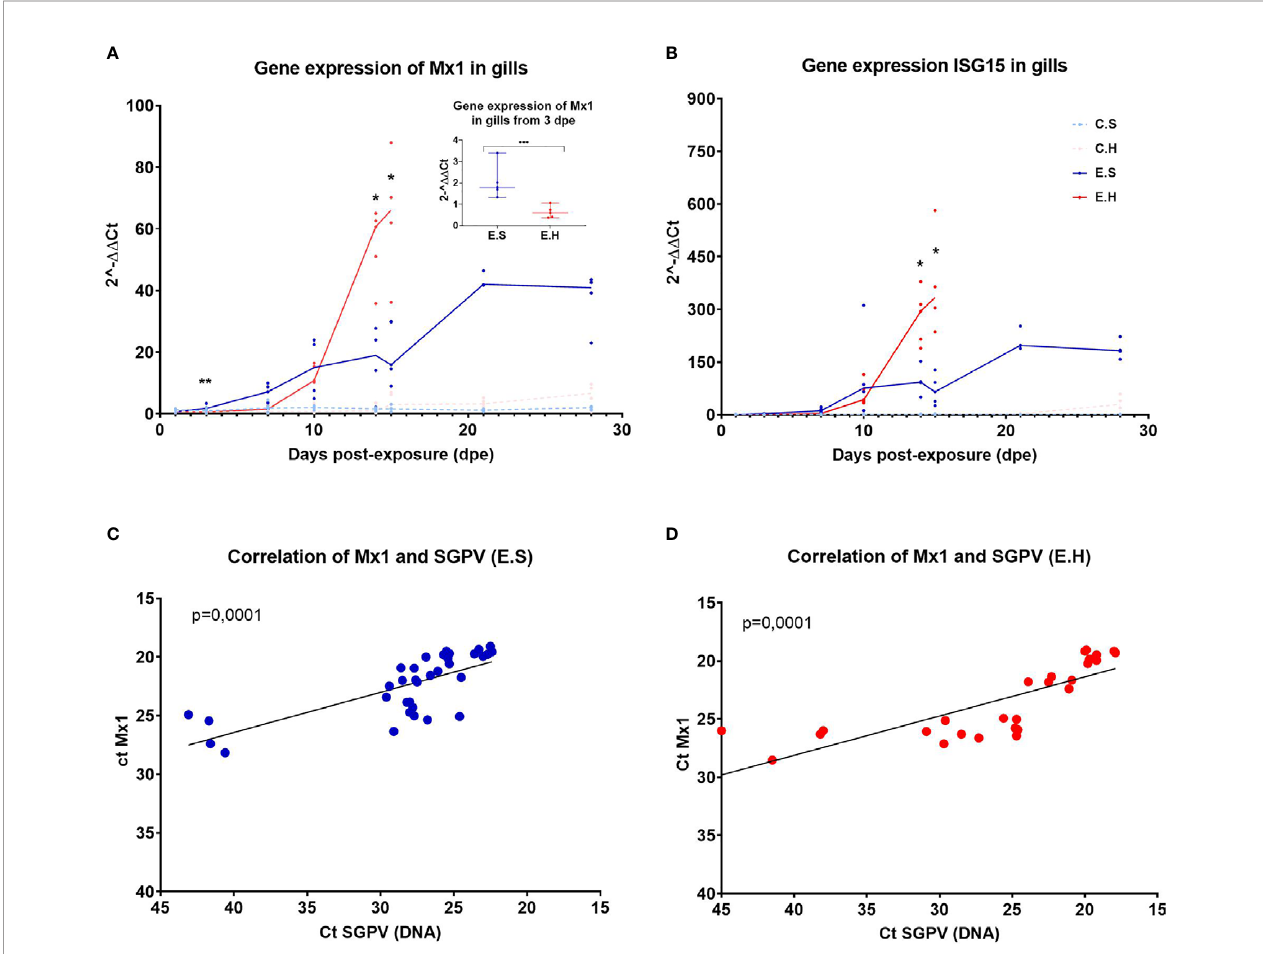
FIGURE 3 | Gene expression of Mx1 and ISG15 in gills from Atlantic salmon from the experimental trial. Each dot represents data from one individual salmon and the solid line represents the median value for each group. The signi fi cant differences are calculated between the two infected groups. (A) Gene expression of MX1 for all groups from day 1 to day 28 in the experimental trial. ( A -insert) Signi fi cant differences between gene expression of MX1 in the two infected groups at 3 dpe. (B) Gene expression of ISG15 for all groups from day 1 to day 28 in the experimental trial. (C) Ct correlation of MX1 and SGPV DNA (D13L) in the E.S group. (D) Ct correlation of MX1 and SGPV DNA (D13L) in the E.H group. *P < 0.05, **P < 0.01, *** P < 0.001. C.S, Uninfected control sham injected group; C.H, Uninfected control hydrocortisone-injected group; E.S, SGPV-exposed sham injected group; E.H, SGPV-exposed hydrocortisone-injected